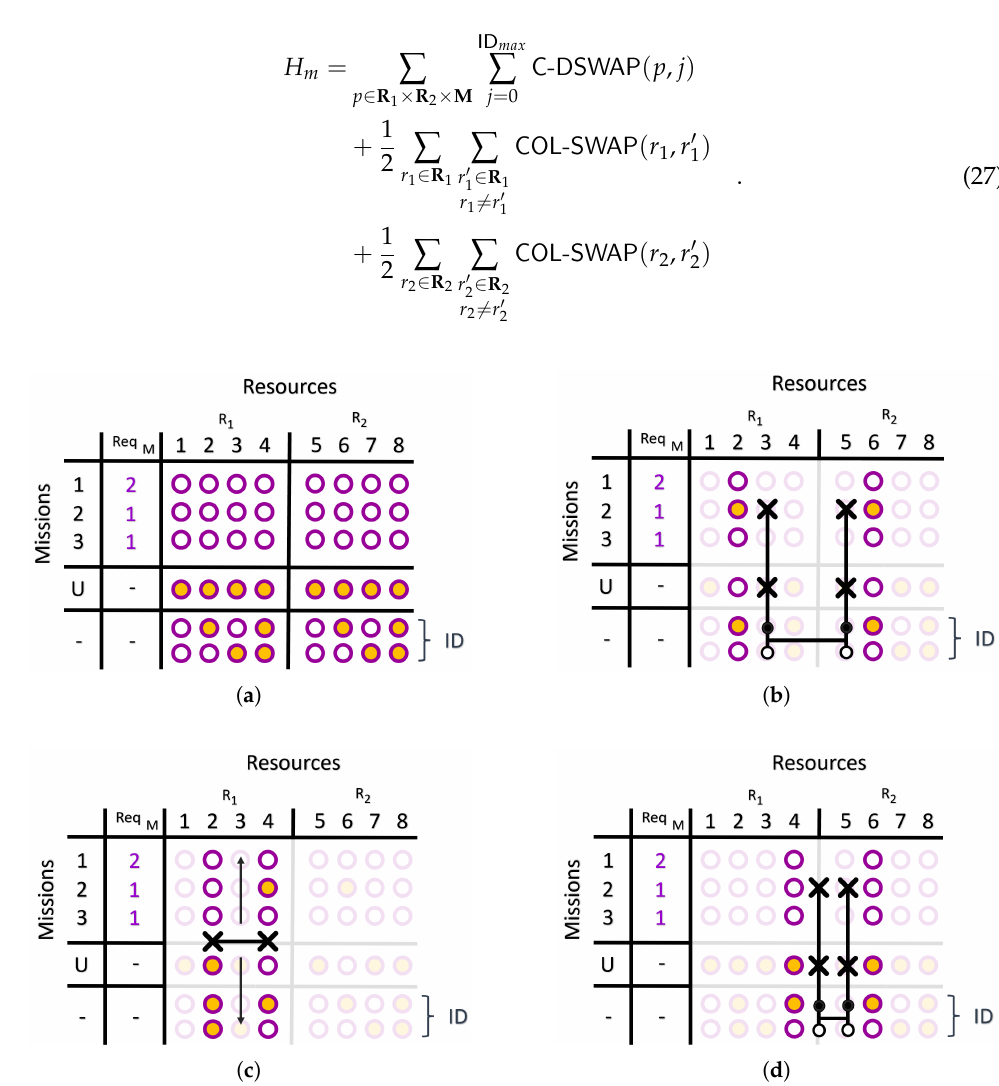
Figure 5. ( a ) Initial State Layout. The initial state is similar to the QAOA case except with additional ID qubits to be used to support the constraint mixer. Each column of ID qubits forms a unique binary number for that resource within its resource set. ( b ) First Control Dual-Swap Operation. Through mixing, resource 2 is allocated to mission 2. In order to not violate the row constraint, resource 6 from R 2 is allocated using a dual-swap gate with controls on the ID qubits. ( c ) Column Swap. The mixing operator can never produce a valid solution where just resource 4 and 6 are paired to mission 2 using just Controlled Dual-Swap Operations. Therefore, column-swap operations are permitted, which swap any two columns in the table within its resource set. Here, resource 2 and 4 in resource set R 1 have their entire columns swapped. ( d ) Second Control Dual-Swap Operation. This operation is exactly the same as ( b ), but the Control Dual-Swap operator is used to unallocate resource 4 from mission 2 to mission U . Notice that the Control Dual-Swap operator has its control configuration identical on both resource 4 and 6 ID-qubit columns; this is to ensure that the row constraint cannot be violated. A violation occurs when leaving resource 6 with no pair on mission